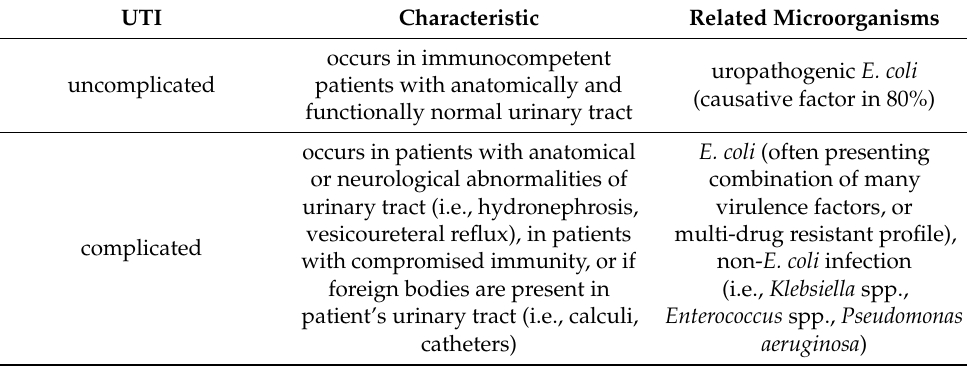
Table 1. UTIs classification according to complicating factors